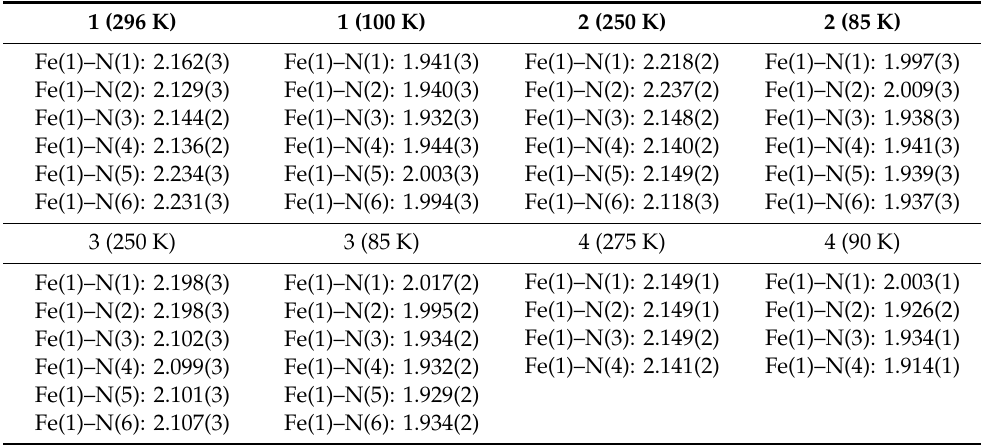
Table 2. Selected Fe-N bond lengths for 1 – 4